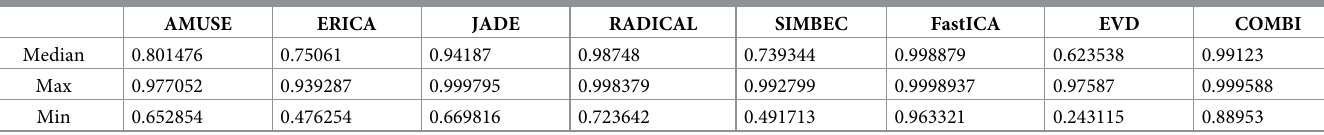
Table 11. SCC values between the most reliable Infomax results and the other nine results (motor data).